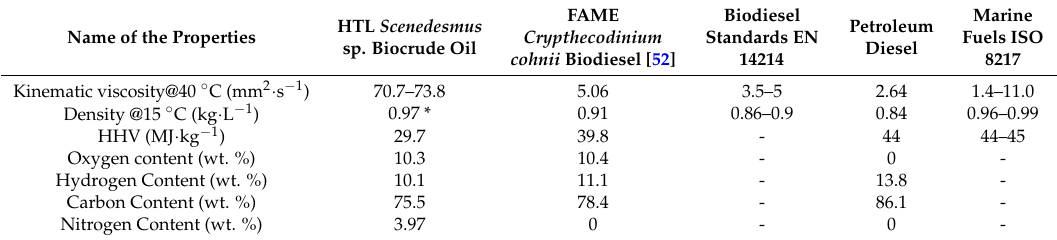
Table 5. Comparison of chemical and physical properties of bio-crude produced at 350 ◦ C and 25% solids with trans-esterified microalgae biodiesel, diesel, biodiesel, and marine fuels standards. *: at 20 ◦